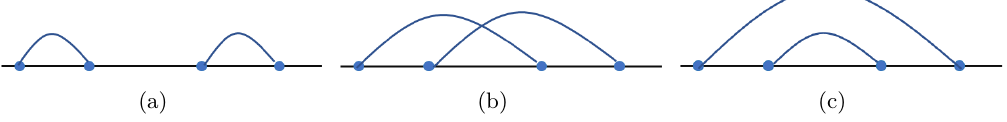
Figure 7 . Three different possible configurations of extremal surfaces for two spacelike intervals in planar CFT 2